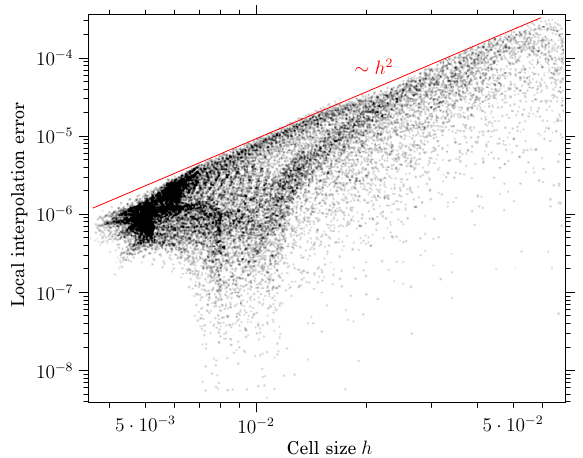
Figure 6. When mapping between non-uniform hexagonal meshes, the local error depends quadratically on the local resolution. Each dot represents a grid cell. The cell size h is computed as the square root of the cell area.